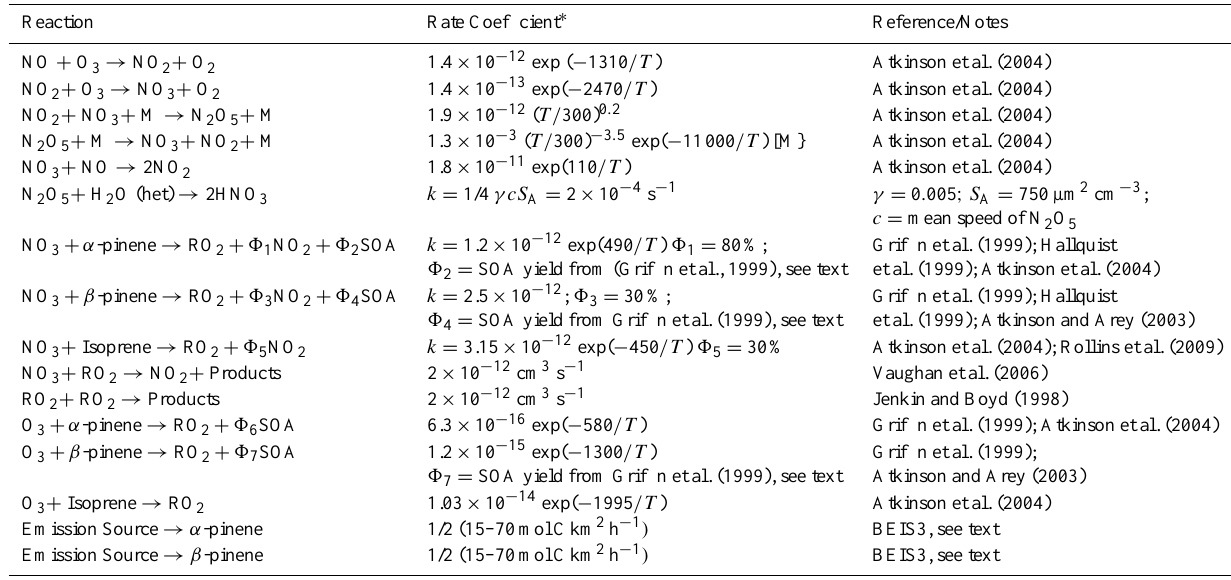
Table 3. Chemical mechanism for nighttime box model.